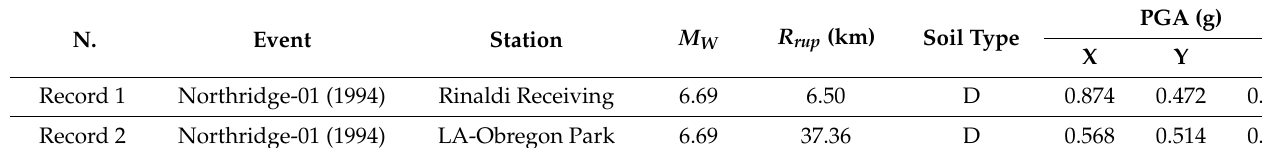
Figure 3. Lumped mass model of the examined 9-storey steel building with and without DFP bearing (XZ plane). Table 1. The characteristics of the ground motions.